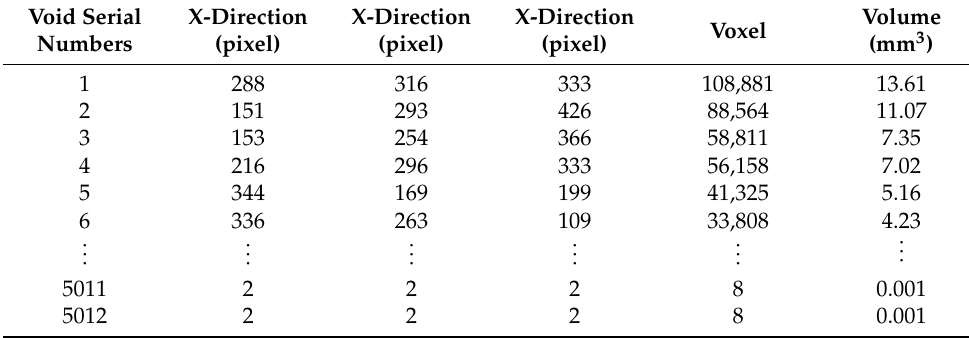
Table 3. Measurement results of air voids.